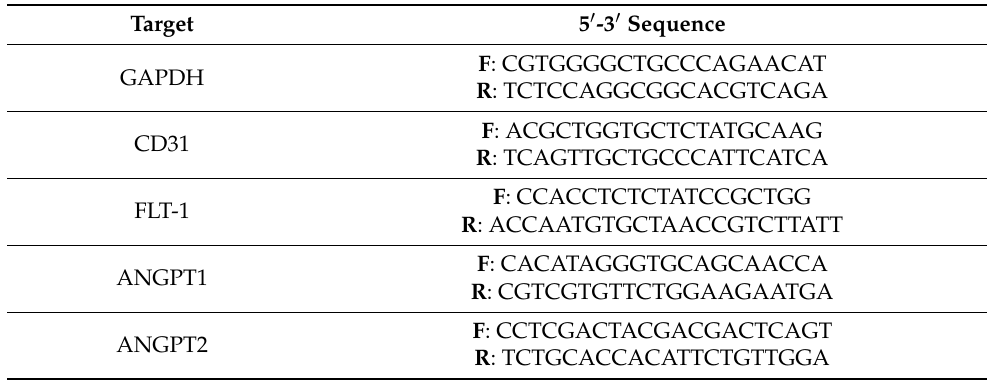
Table 3. Primer Sequences used for Quantitative